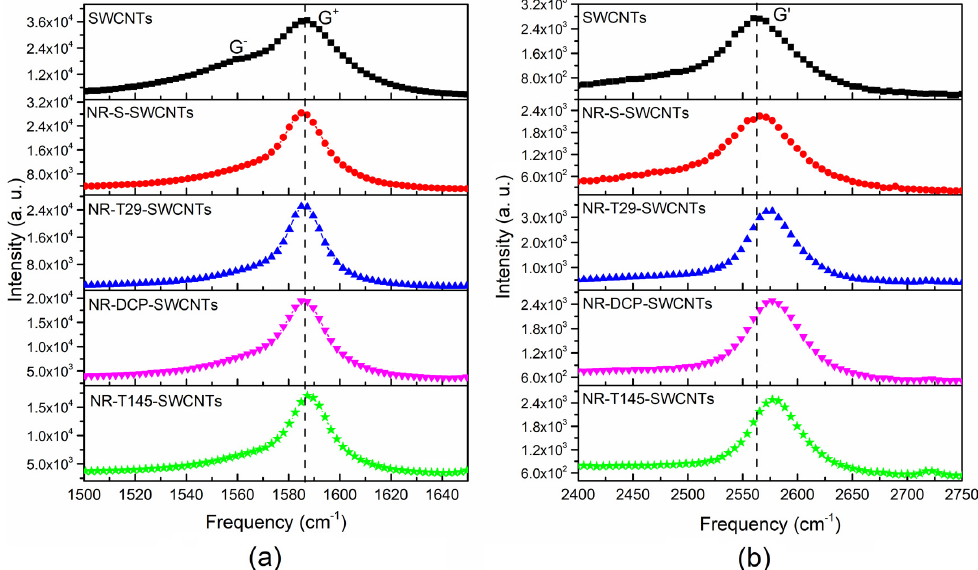
Figure 8. Raman spectra of ( a ) G-, and ( b ) G’-band of the NR-SWCNTs composites using different cross-linking agents.